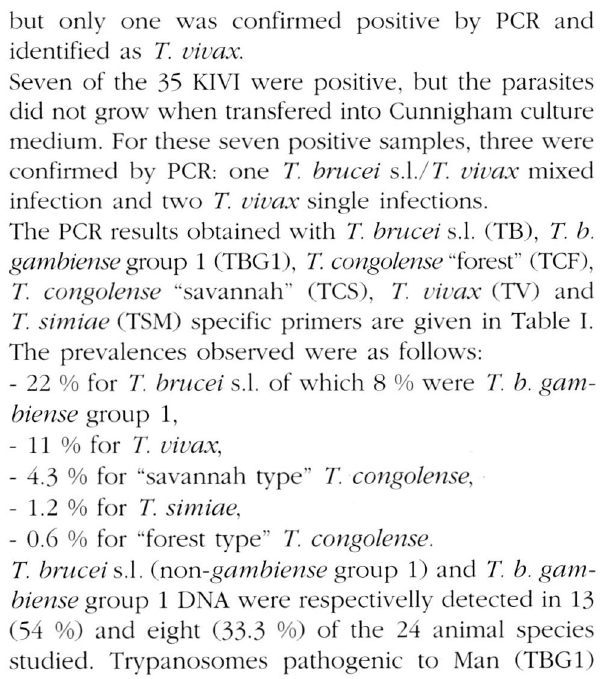
but only one was confirmed positive by PCR and identified as T.